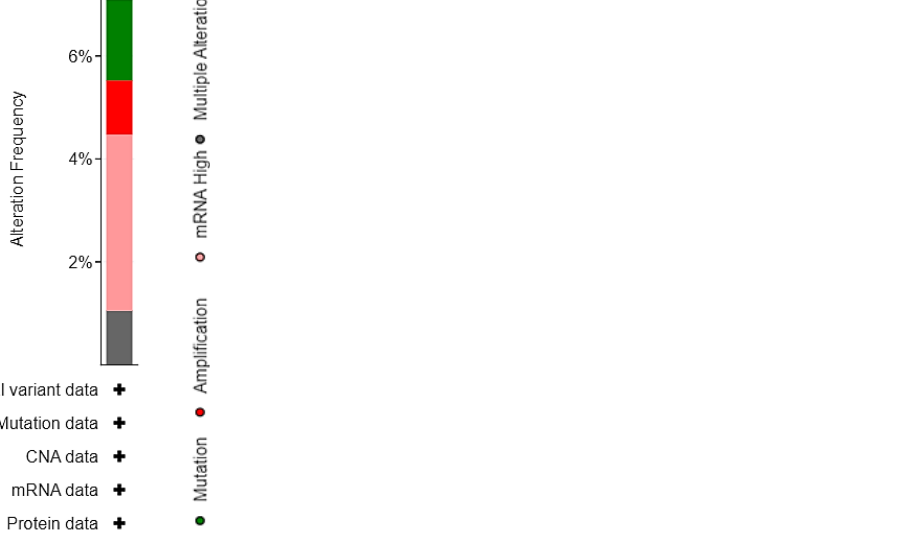
Figure 3. Distribution of EPAS1 molecular alterations in MSK/TCGA 2020 cohort (n = 476). Table 1. EPAS1 mutations in MSK/TCGA 2020 cohort (n = 476). # Total number of nonsynony- mous mutations.